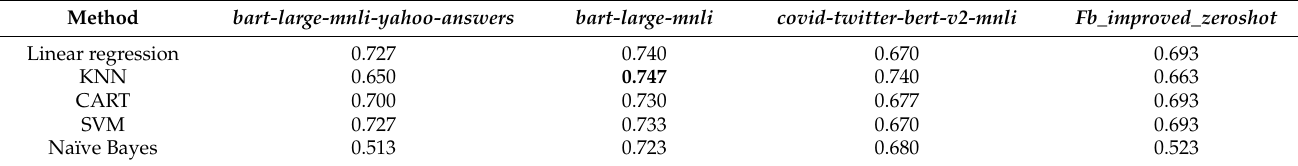
Table 4. The impact of zero-shot models on the accuracy of machine learning classifiers for the binary sentiment classification with the Sentiment140 dataset. The best result is shown in bold.